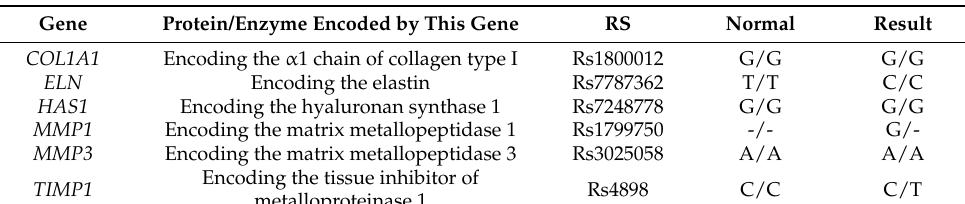
Table 1. The result of the genetic analysis of genes responsible for the structure of the extracellular matrix.